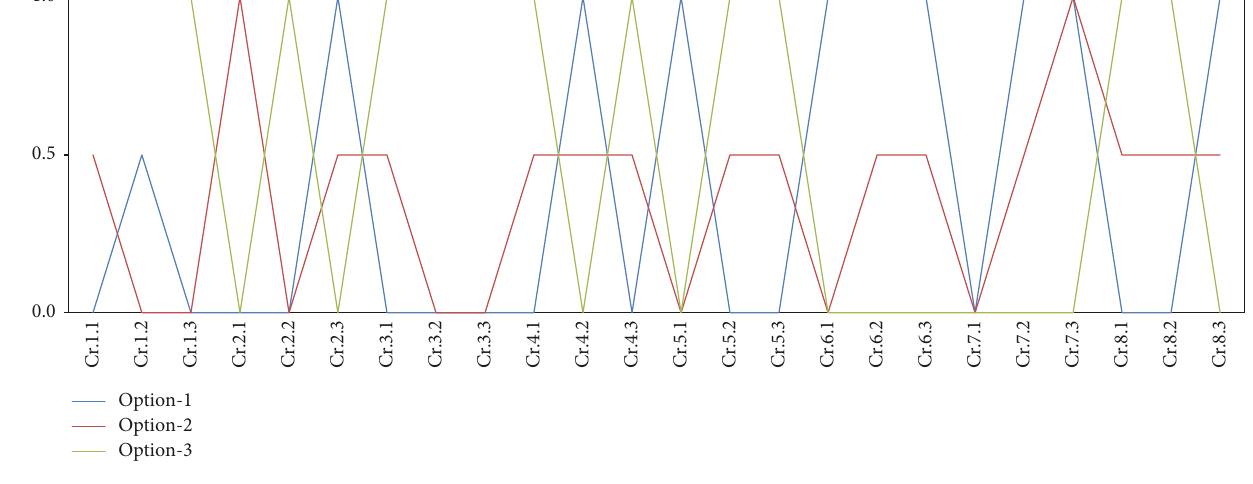
Figure 3: Value path.